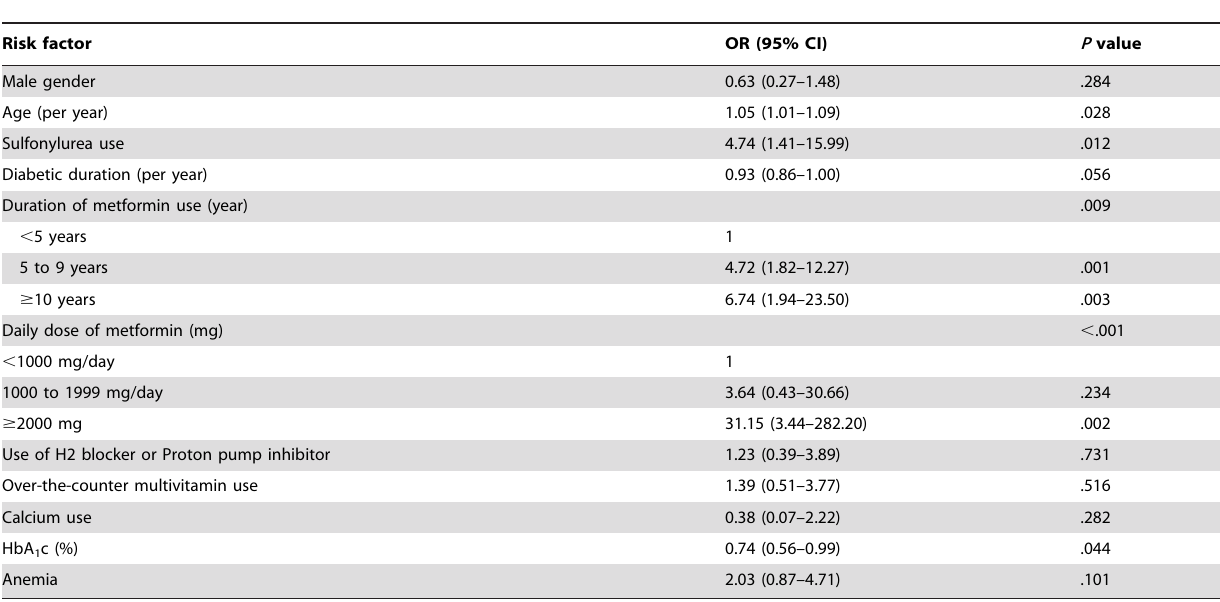
Table 4. Logistic regression analysis for potential risk factors of Vitamin B 12 deficiency among patients with type 2 diabetes.